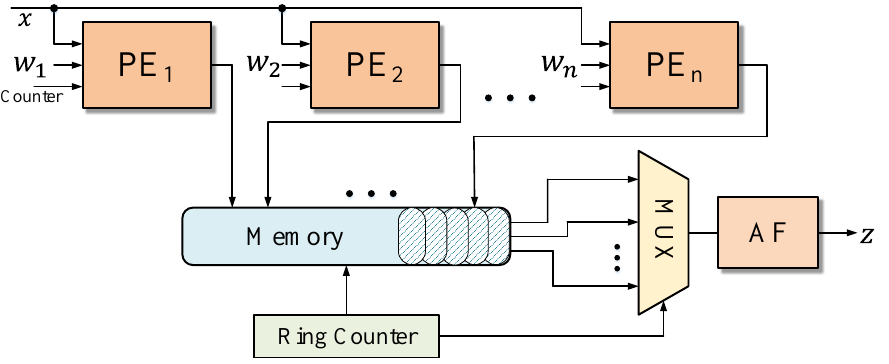
Figure 4. The detail structure of each neural